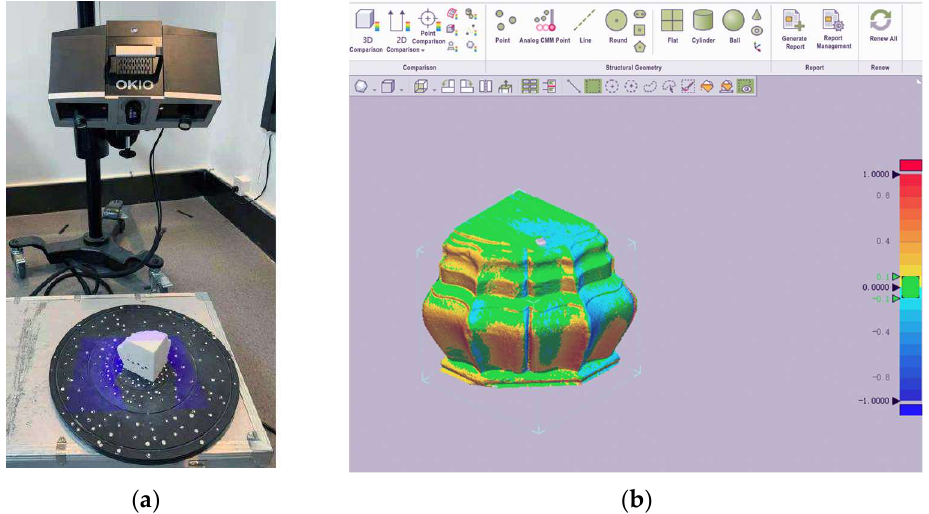
Figure 5. ( a ) Three-dimensional scanning of experimental samples; ( b ) experiment sample forming inaccuracy detection.